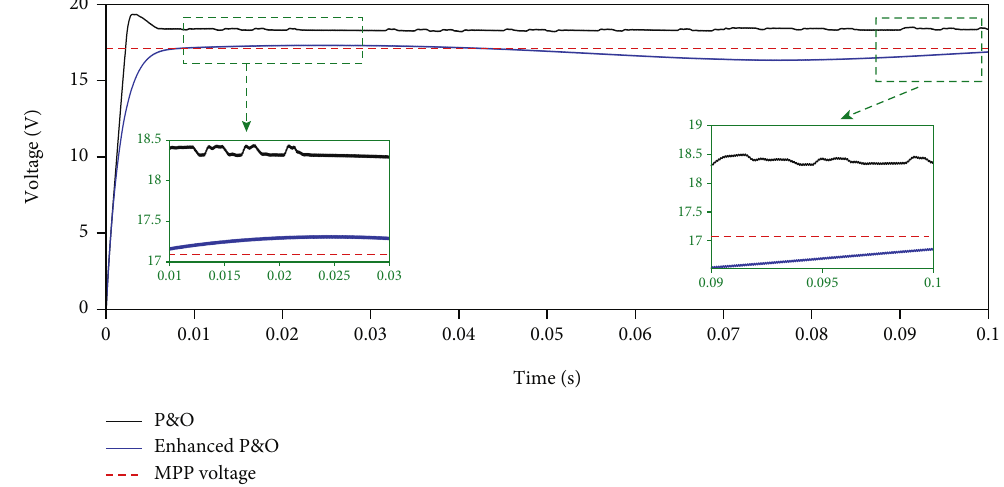
Figure 20: Tracking of MPP voltage with P&O and enhanced P&O MPPT method under Test